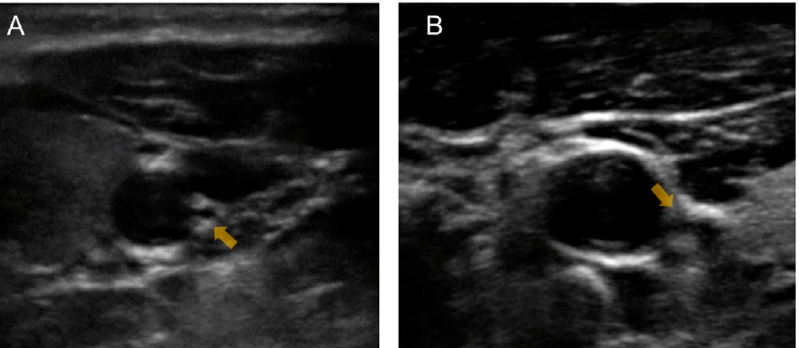
Figure 3. The visualized vagus nerve and its anatomical relationship with CCA and IJV by ultrasonography in case 1 ( A ) and case 2 ( B ). Although the vagus nerve was detectable in case 1, its location was unclear in case 2 (arrow).